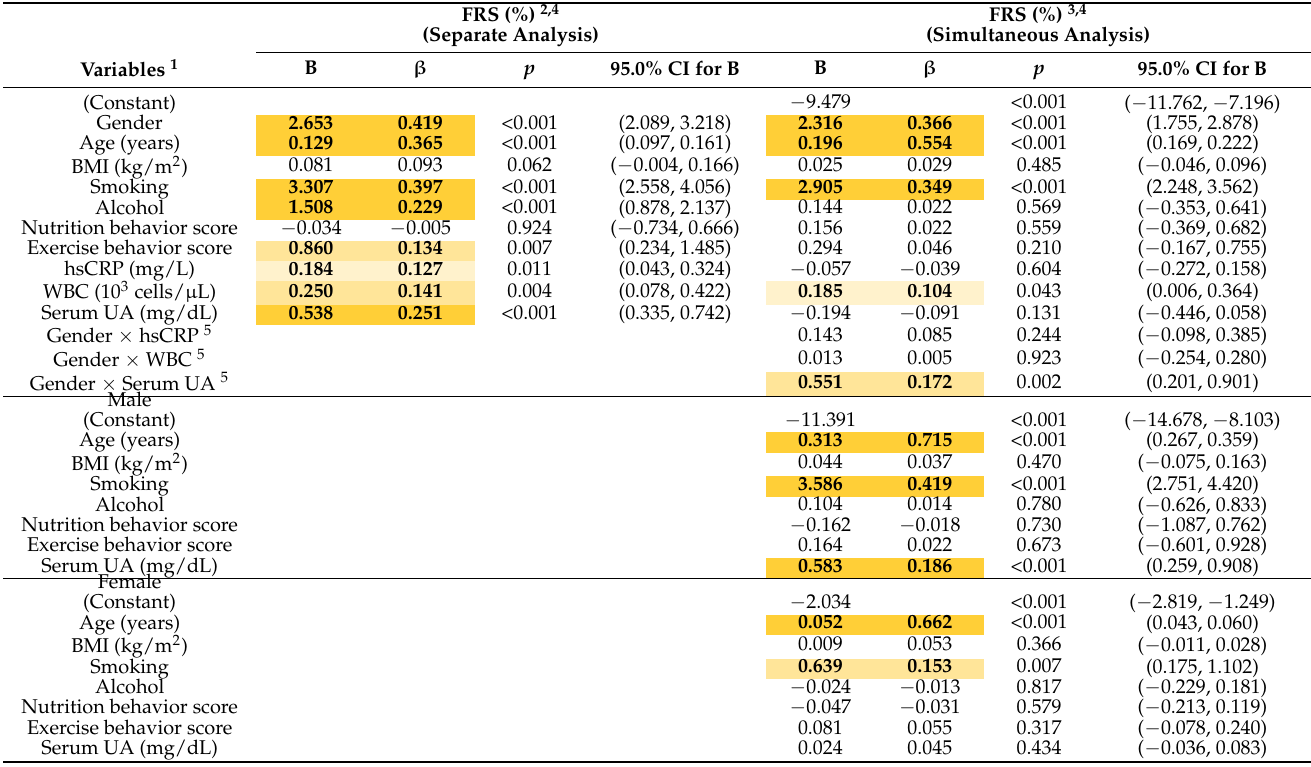
Table 4. Simple and multiple linear regressions for FRS in relation to CVD risk